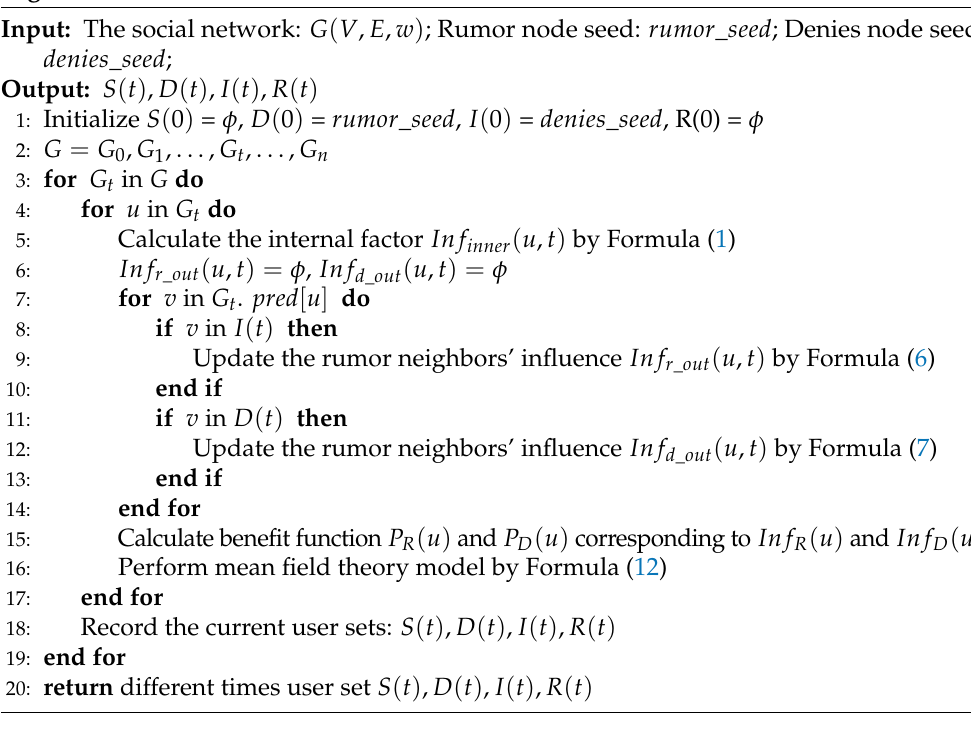
Algorithm 1 SDIR Model